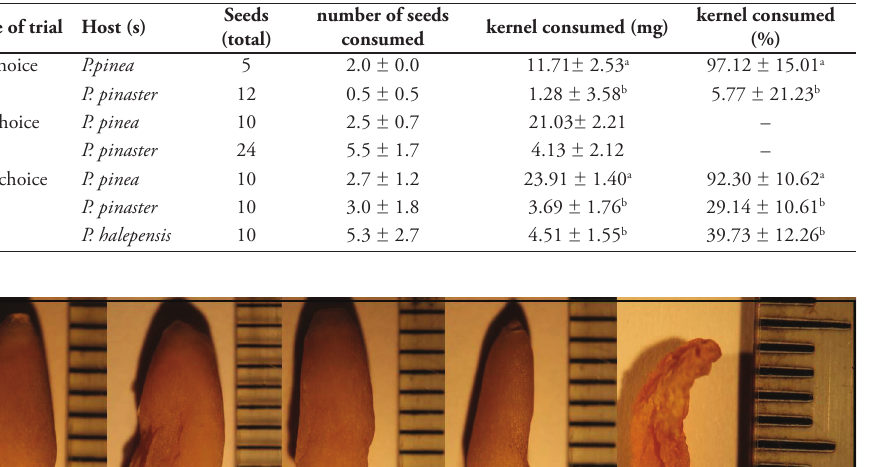
Table 3. Seed consumption in choice and non-choice trials. Average number ( ± SE) of consumed seeds per box, kernel weight consumed per box and bug and percentage of the kernel that was consumed in each of the seed preference trials. Different letters within a trial indicate significant differences between the values per host species after GLM tests (p-value=0.05).